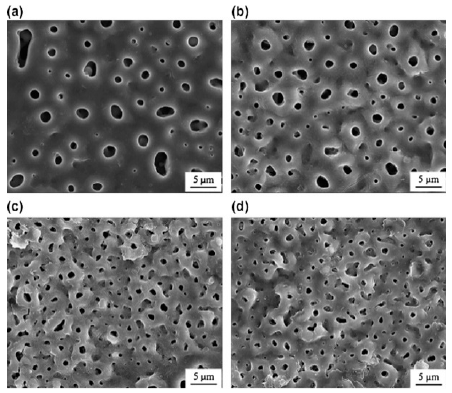
Figure 4. SEM micrographs of MAO coating structures under different frequencies of ( a ) 60 Hz, ( b ) 500 Hz, ( c ) 1000 Hz, and ( d ) 2000 Hz [40].